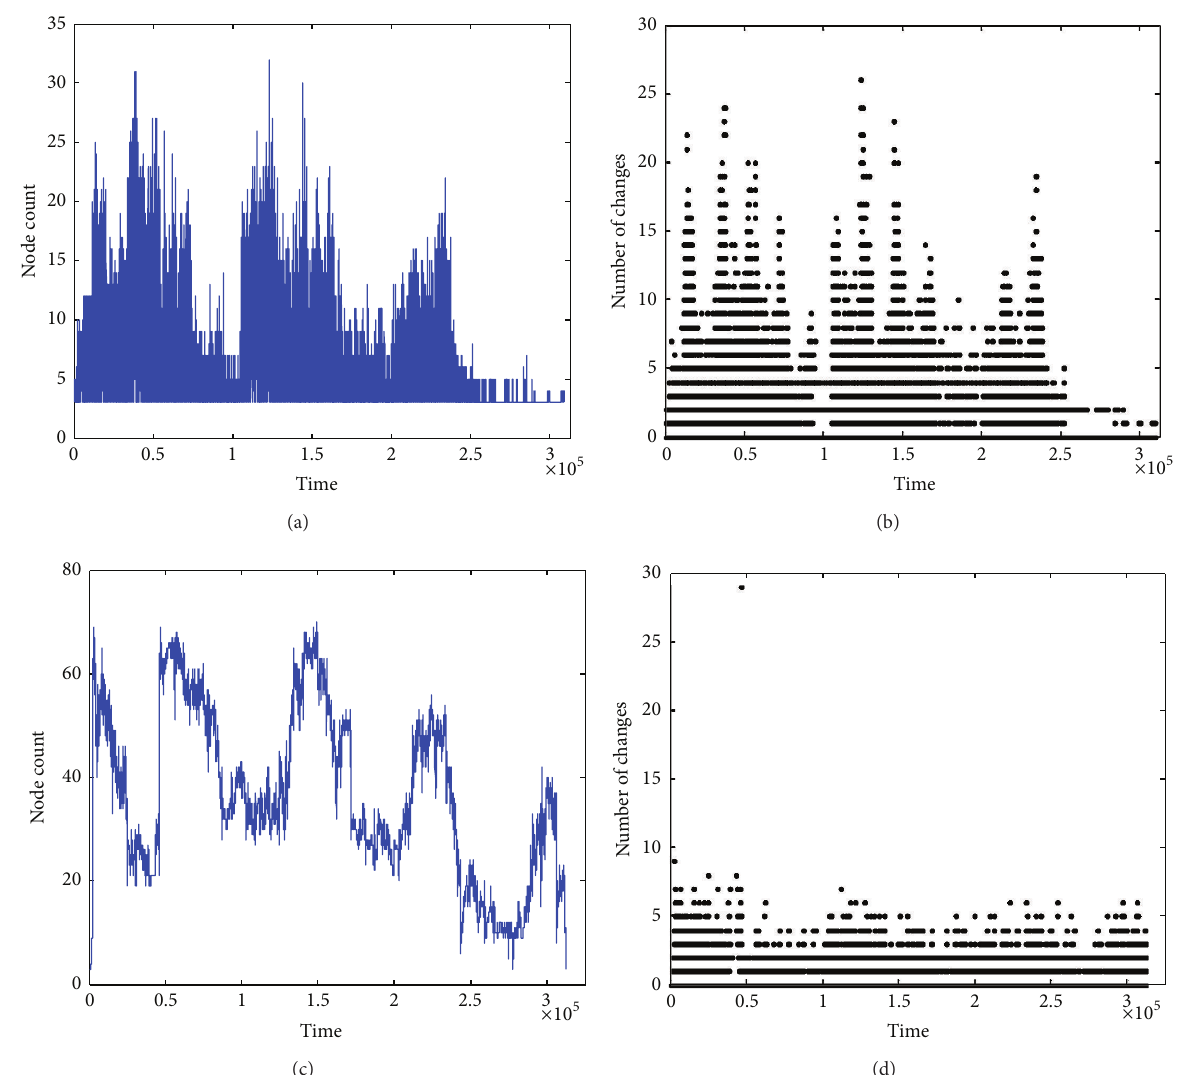
Figure 9: Number of nodes in community detected by COPRA. (a) Node number at each timestamp in communities (SIGCOMM09). (b) Number of node changes in community between two consecutive timestamps (SIGCOMM09). (c) Node number at each timestamp in communities (SIGCOMM09). (d) Number of node changes in community between two consecutive timestamps (INFOCOM06).